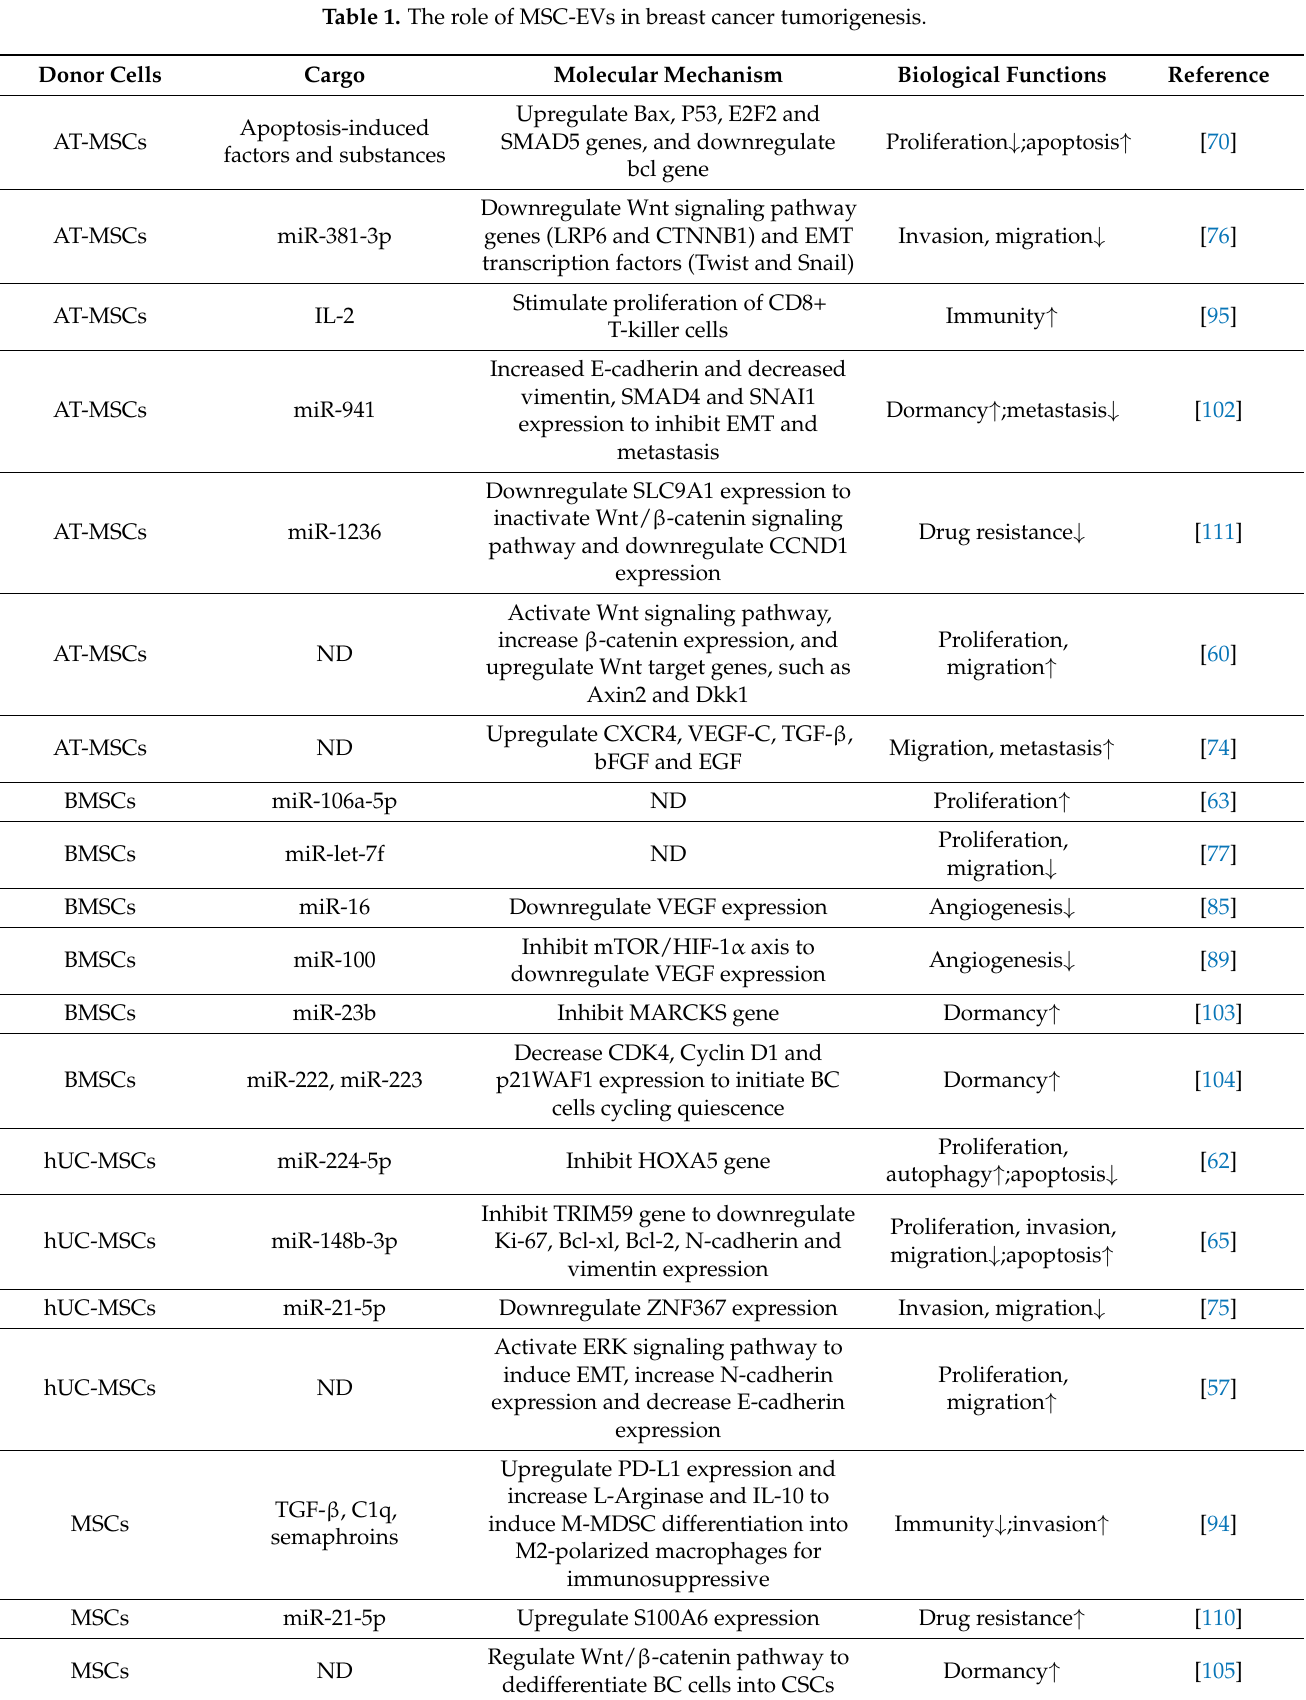
Table 1. The role of MSC-EVs in breast cancer